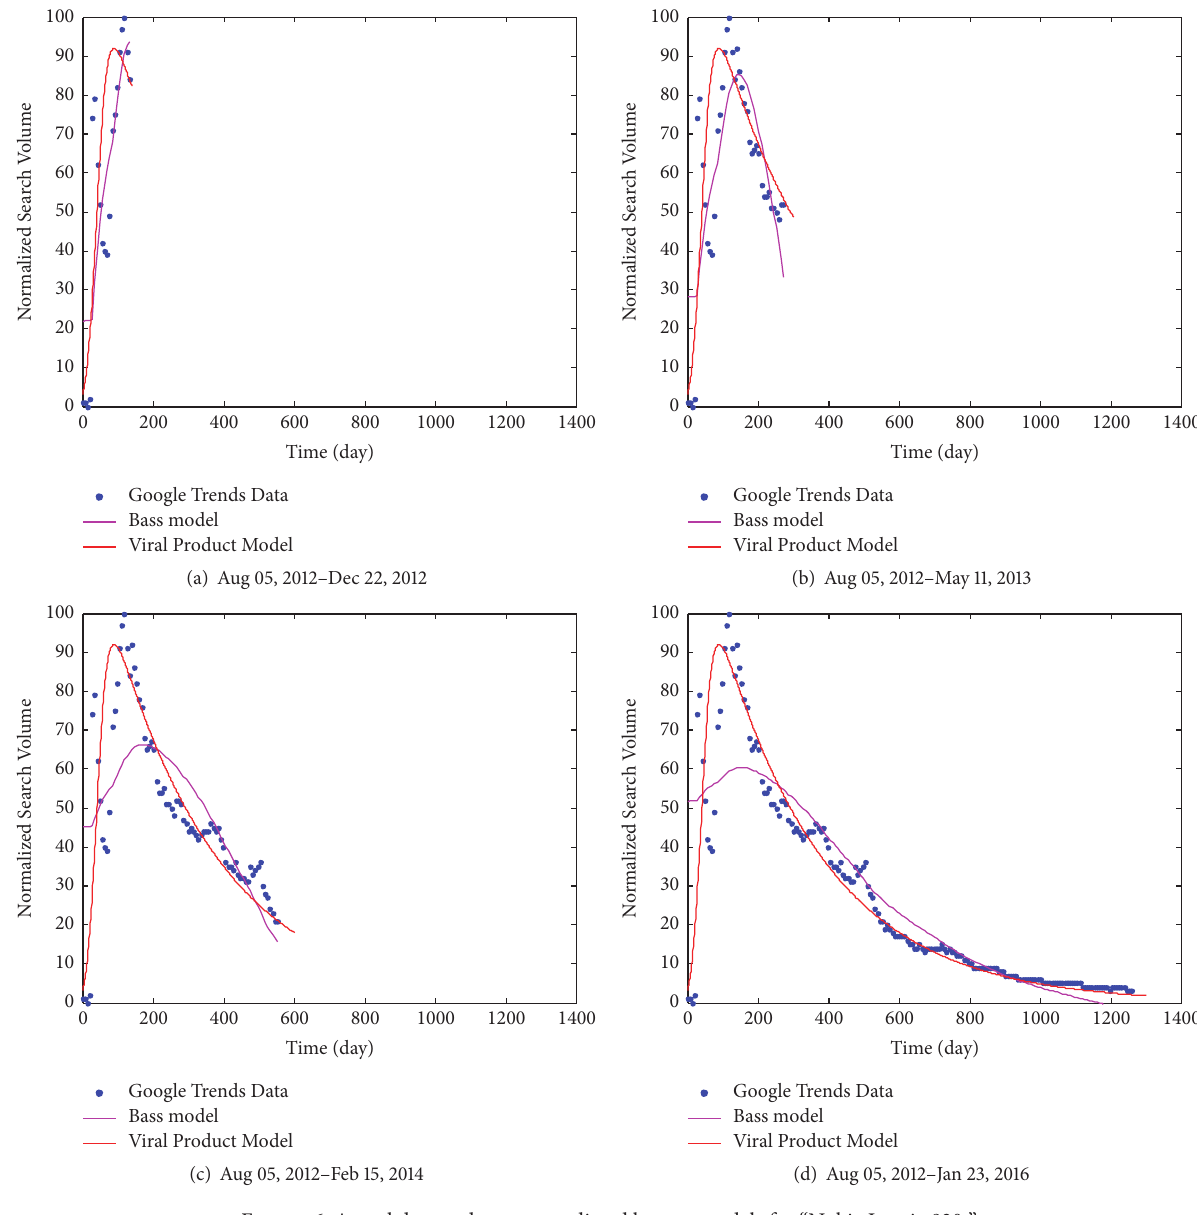
Figure 6: Actual data and curves predicted by two models for “Nokia Lumia 920.”